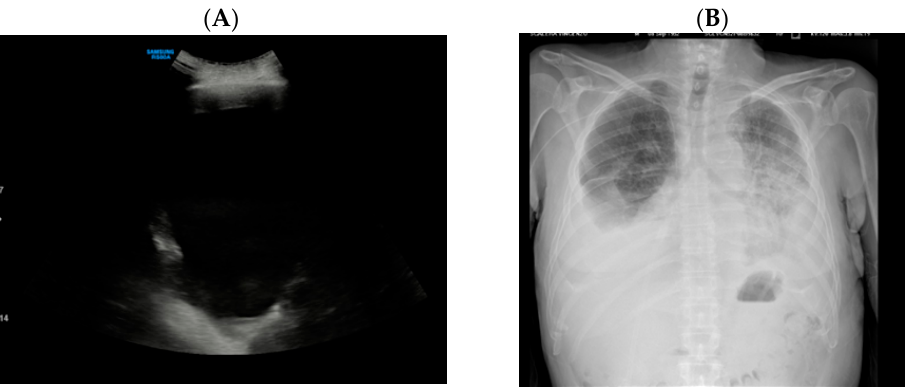
Figure 5. February 2022. ( A , B ) Sharp worsening of pulmonary interstitial disease in chest X-ray and pleural effusion on abdominal ultrasound.